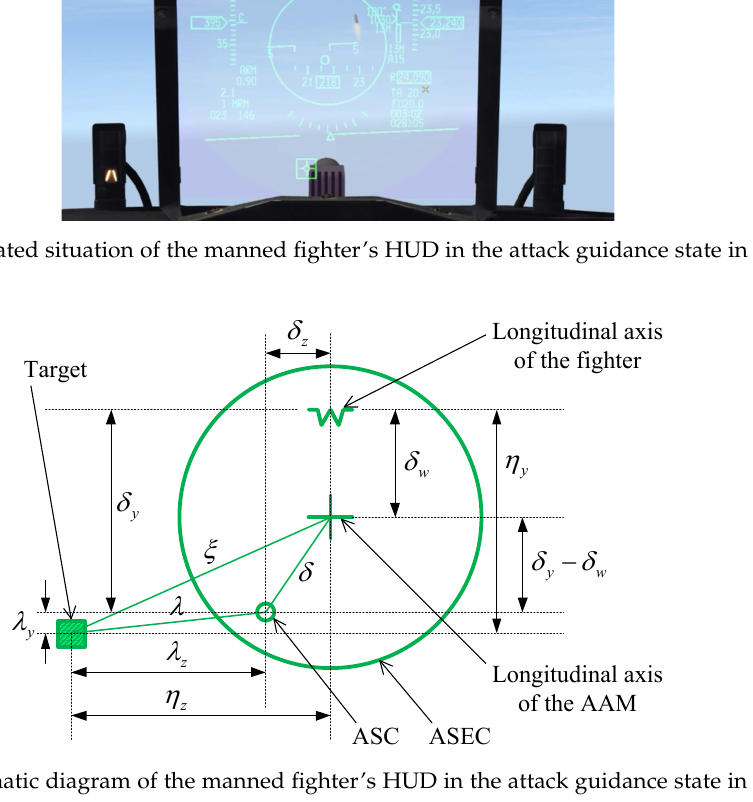
Figure 2. Schematic diagram of the manned fighter’s HUD in the attack guidance state in the BVR air